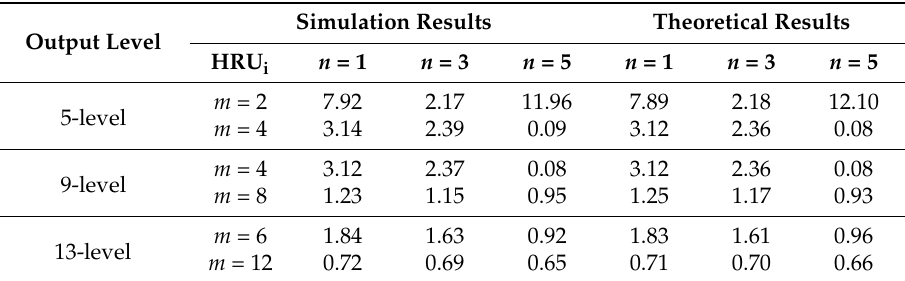
Table 4. Comparison between Simulation Results and Theoretical Results.